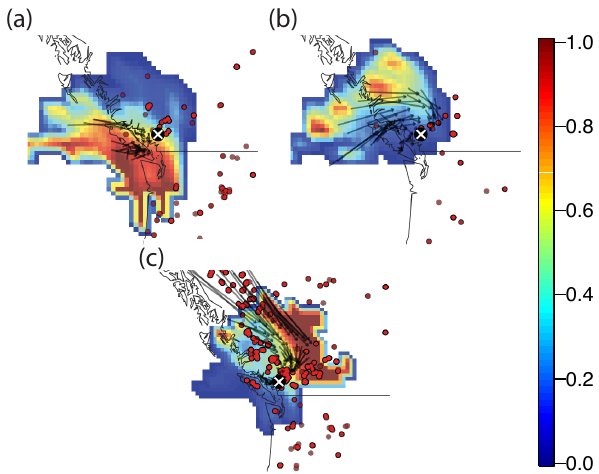
Fig. 8. Potential Source Contribution Function (PSCF) maps shown for (a) periods not corresponding to biogenic or biomass burning events (anthropogenic combustion/other), (b) periods identified as having been impacted primarily by non-burning forest emissions, and (c) periods identified as having been impacted primarily by biomass-burning emissions. Black lines indicate coastline and US- Canadian border. Heat map coloring represents the probability of source contribution (blue=low, red=high) at each location, though for remote sources, warmer (red) colors may only indicate gen- eral direction of source. Black arrows indicating wind vectors are superposed (from NOAA HYSPLIT backtrajectory simulations). Whistler Peak measurement site is marked by a white x in each map. Red circles indicate locations of fires by satellite imagery (source: Natural Resources Canada,